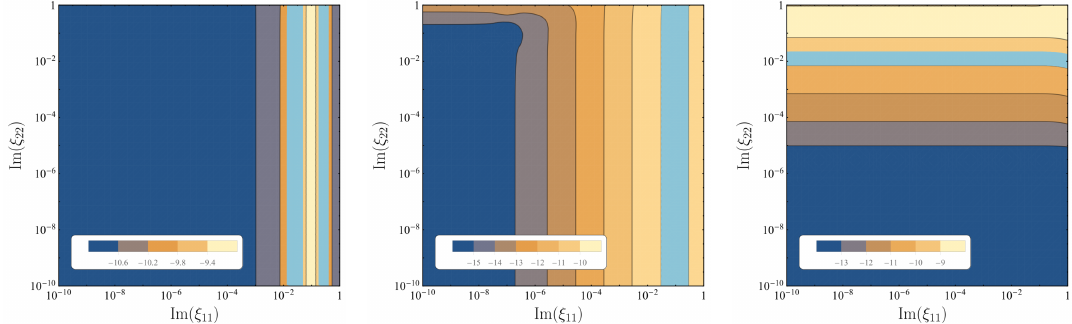
Figure 8 . The density plots of the lepton asymmetry in the (Im ξ 11 , Im ξ 22 ) plane for the normal mass hierarchy. (Left) Im ξ = 10 − 1 / 2 , Re ξ = 10 − 1 / 2 . (Middle) Im ξ 12 12 (Right) Im ξ = 10 − 5 , Re ξ = 10 − 1 / 2 12 22